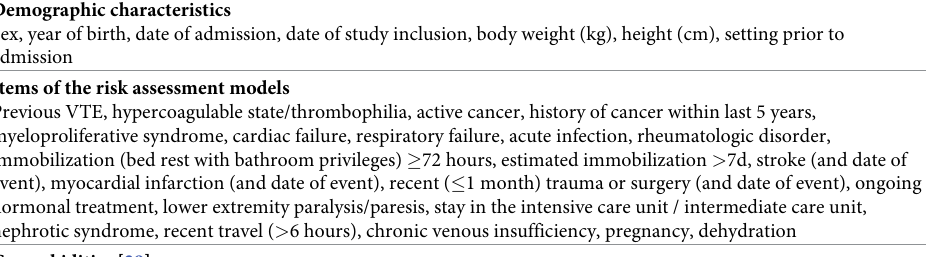
Table 1. Baseline data